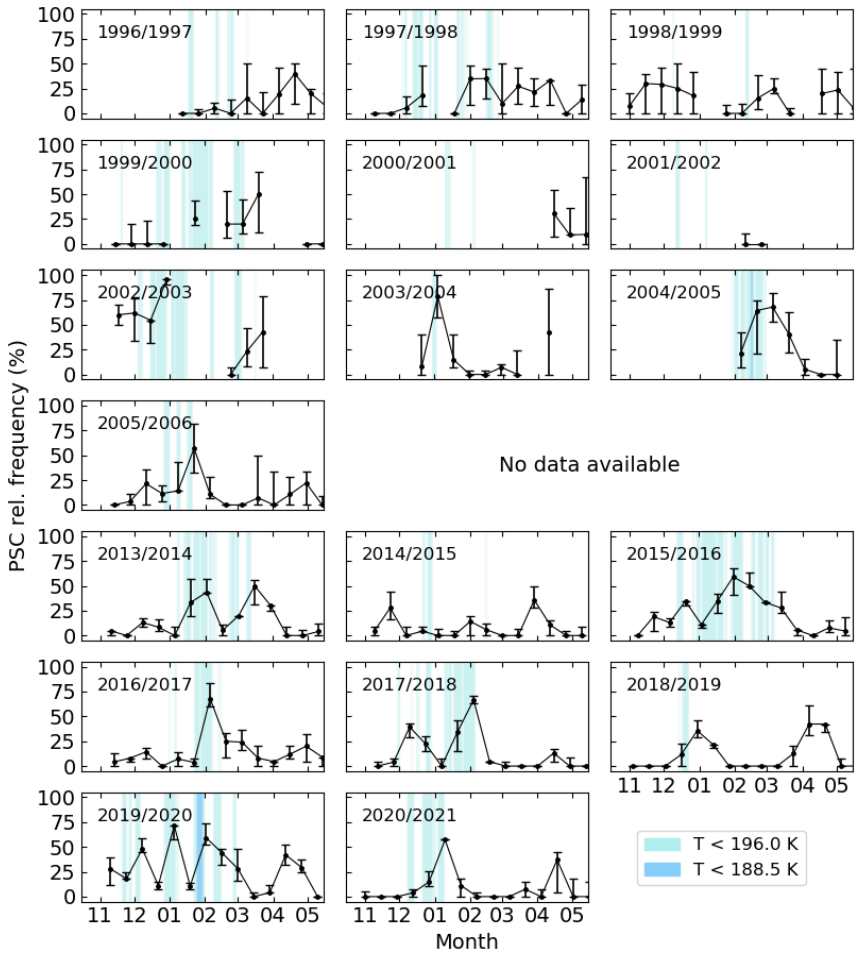
Figure 12. Biweekly relative frequency of PSCs in the UV spectral range for each year from November to May above Kiruna. In the background, the temperature ranges important for PSC formation are indicated by the blue shading. Data are plotted from the ECMWF subset (at 50hPa) sampled in the vicinity of the measurement